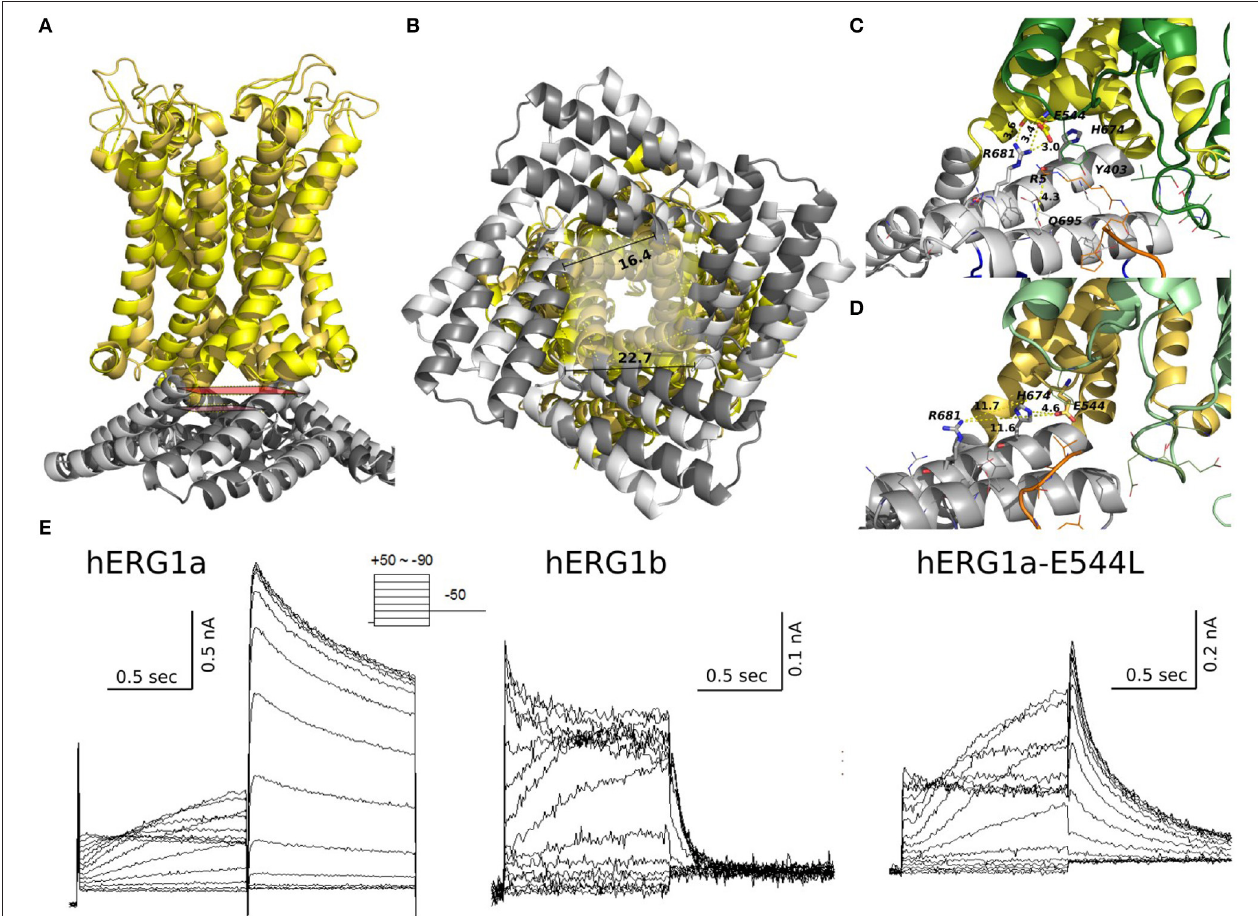
FIGURE 10 | Structural alignment of closed (light colors) and open (dark colors) models of hERG. TM and C-linker side view shows that the C-linker/TM are closer to each other in the open state compared to the closed (A) . Distances between residues Gly669 show that a closer C-linker is a consequence of a more open pore in the open state (B) . Key salt bridge interactions between Glu544 and Arg681 can only be found in the open state (C) but not in the closed state (D) . (E) Current traces from experiments previously published by Durdagi et al. for hERG1a, hERG1b, and hERG1a-E544L elicited by the voltage protocol at the top. E544L mutant displays a faster deactivation rates than WT but not as much as